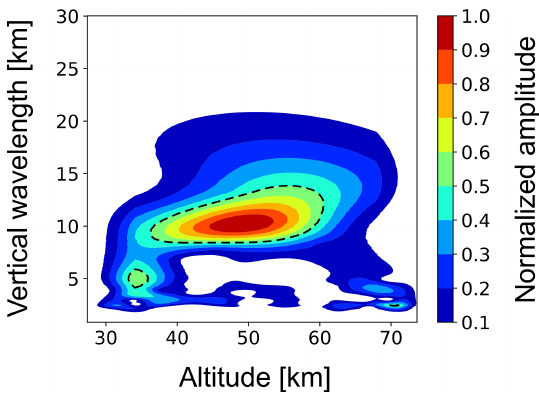
Figure 6. Combined wavelet transform of profiles shown in Fig.